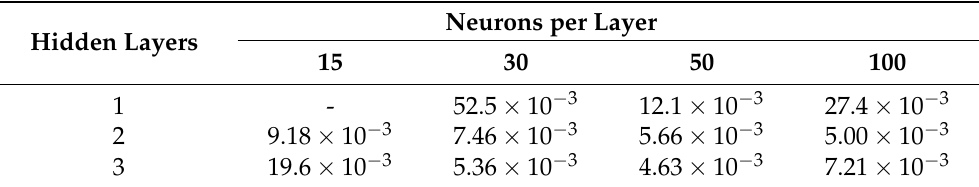
Table 1. Normalized root-mean-squared error (NRMSE) values of test data for different numbers of hidden layers and neurons per